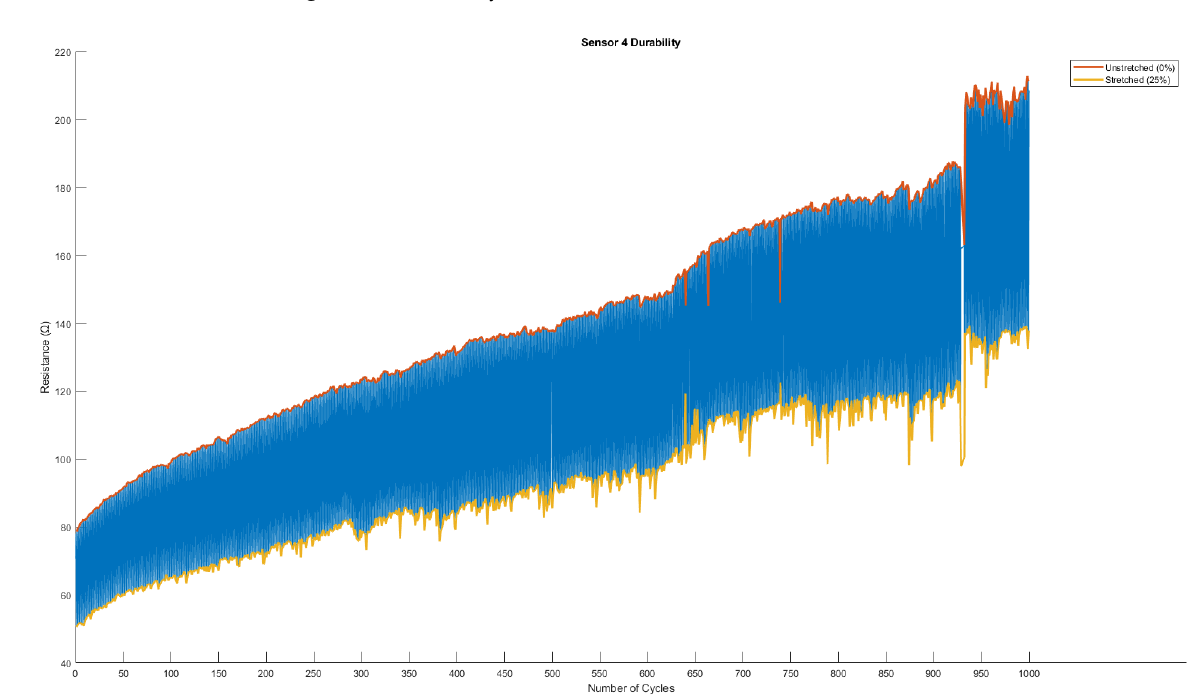
Figure A4. Durability Result